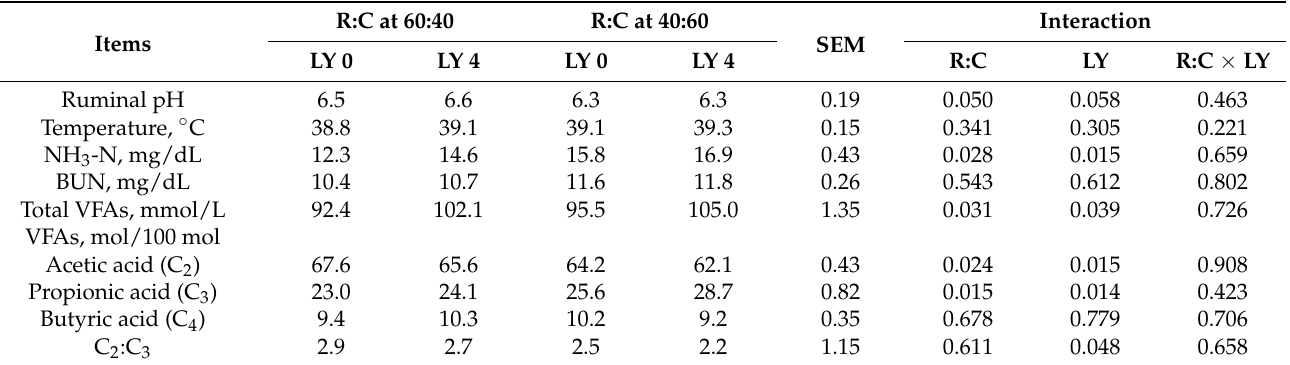
Table 3. Effect of concentrate level and live yeast supplementation on fermentation characteristics and blood urea nitrogen in Thai native beef